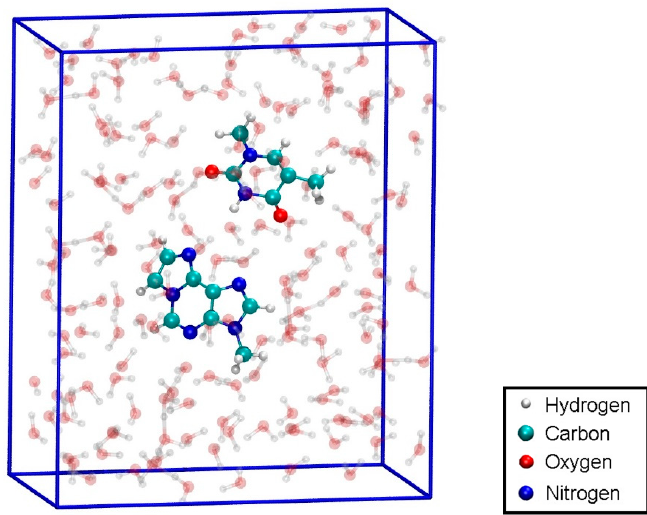
Figure 11. Configuration for the QM dissociation MD of the isolated base pair T : ε A (structure 4 ) with the MM-NPT equilibrated water